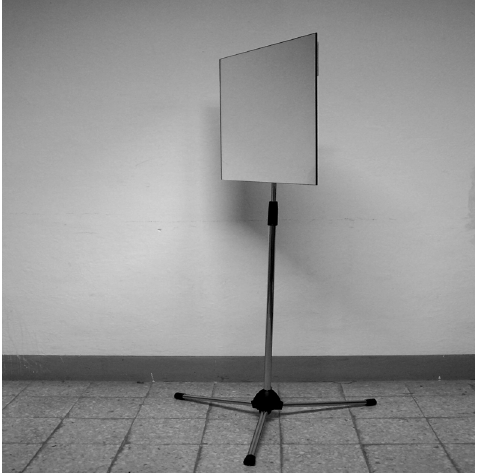
Figure 1. The mirror stand used in the experiment of mirror-gazing. The room should be without external light. A uniform illumination of the face (about 0.8 lux) can be obtained by placing a small lamp, or a candle, on the floor at some distance from the subject’s back [20,21]. The subject’s task is to stare at its eyes in the